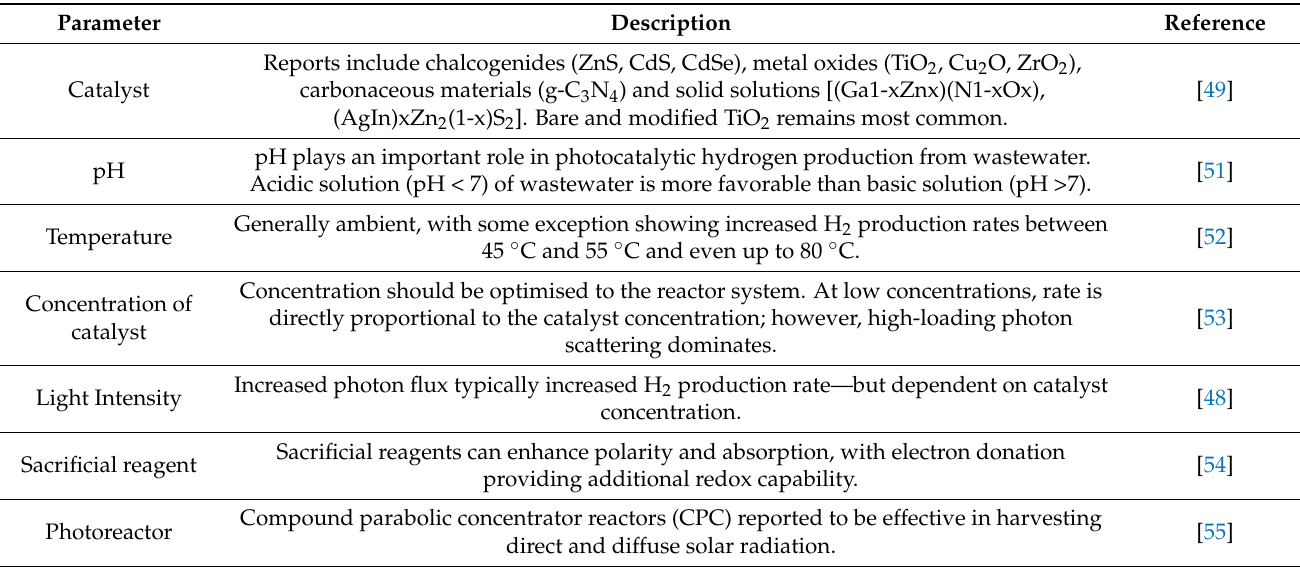
Table 5. Key parameters influencing photocatalytic H 2